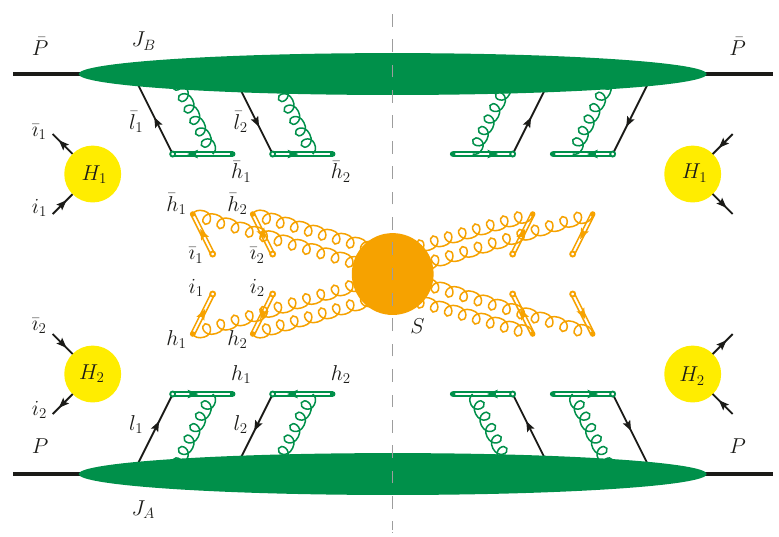
Figure 3 . Structure of the TMD cross section after soft gluons have been decoupled from the collinear